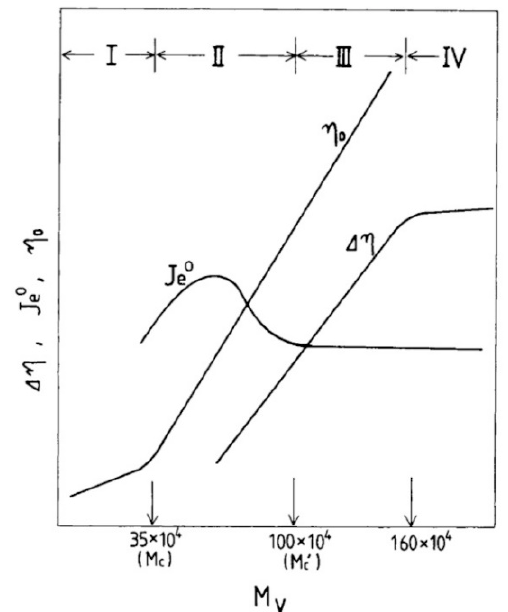
Figure 7. The schematic representation of four molecular weight sections into which the flow mechanism could be categorized based on the network structure. Here η 0 is the zero shear viscosity; J e0 —the steady shear compliance; and ∆ η —the di ff erence between η 0 and the specific viscosity at the steady state. Reproduced from [54], with permission from John Wiley and Sons,